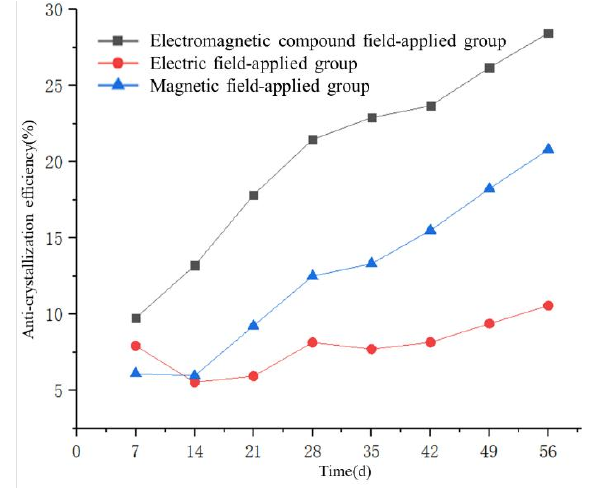
Fig. 8. Changes of anti-crystallization efficiency of the four groups per cycle over